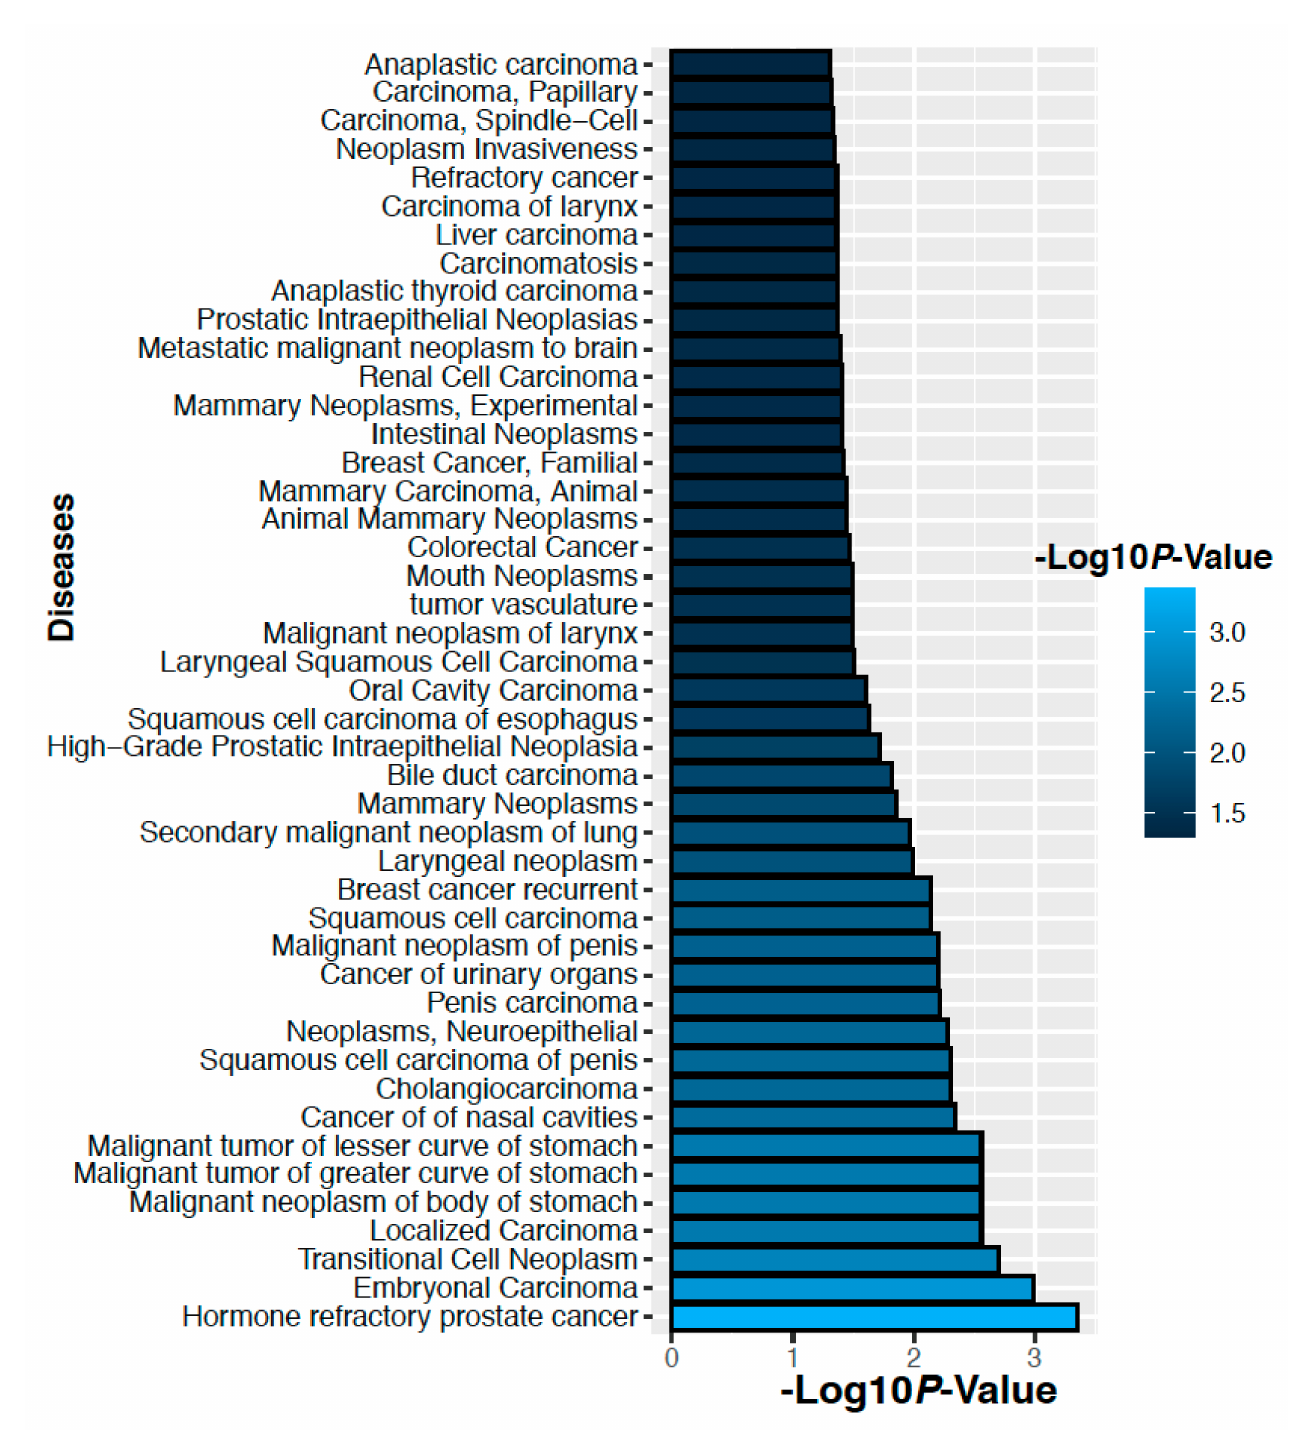
Figure 12. Diseases associated with the genes corresponding to the altered 3 proteins in colorectal